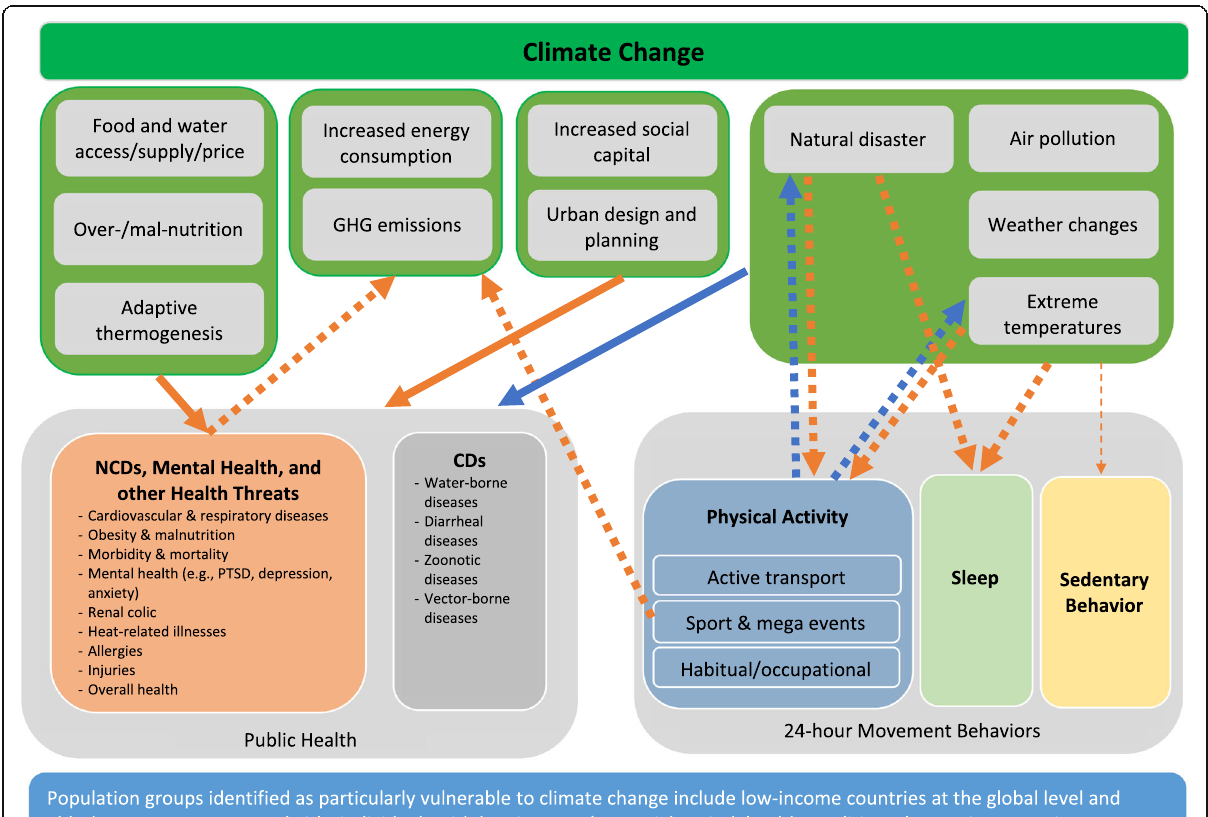
Fig. 2 A conceptual framework of directionalities and pathways between climate change, 24-h movement behaviors, and health. Note : The top circle indicates climate change and below, indicators of climate change that act as both causes and consequences mentioned in each review are listed. From eight reviews included [35 – 42], identified, direction and nature of the relationships between indicators of climate change and varying movement behaviors and/or health outcomes are indicated using arrows (direction) and colored lines (blue lines indicate favorable associations and orange lines indicate unfavorable associations). Furthermore, thick solid lines indicate consistent associations (consistent findings in ≥ two reviews) while thick dotted lines (one review) indicate suspected associations. Narrow dotted lines indicate speculated, but largely unknown associations (no reviews but independent studies). Population groups that are identified as particularly vulnerable are described in the blue box at the bottom. CD: Communicable diseases; NCD: Non-communicable diseases; PTSD: Post-traumatic stress